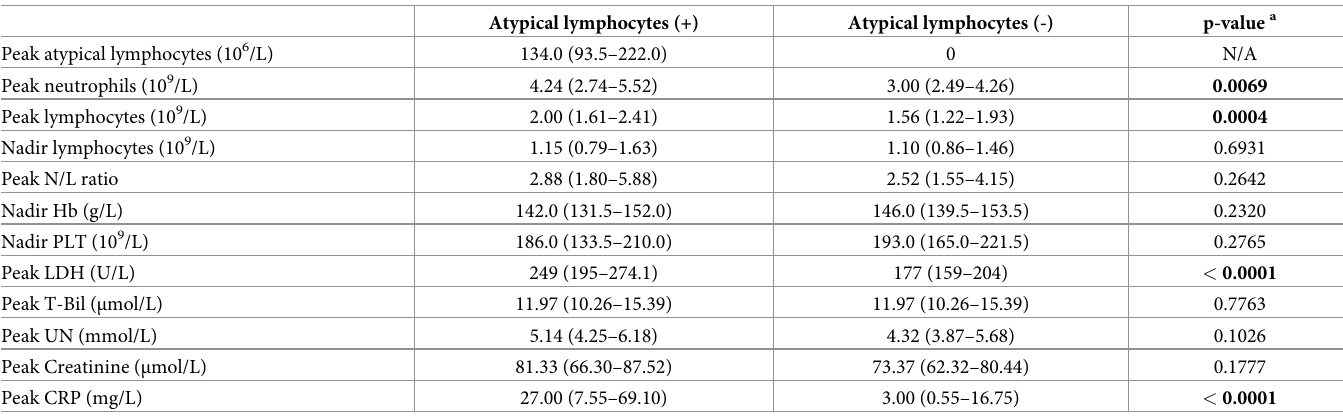
Table 2. Comparison of laboratory